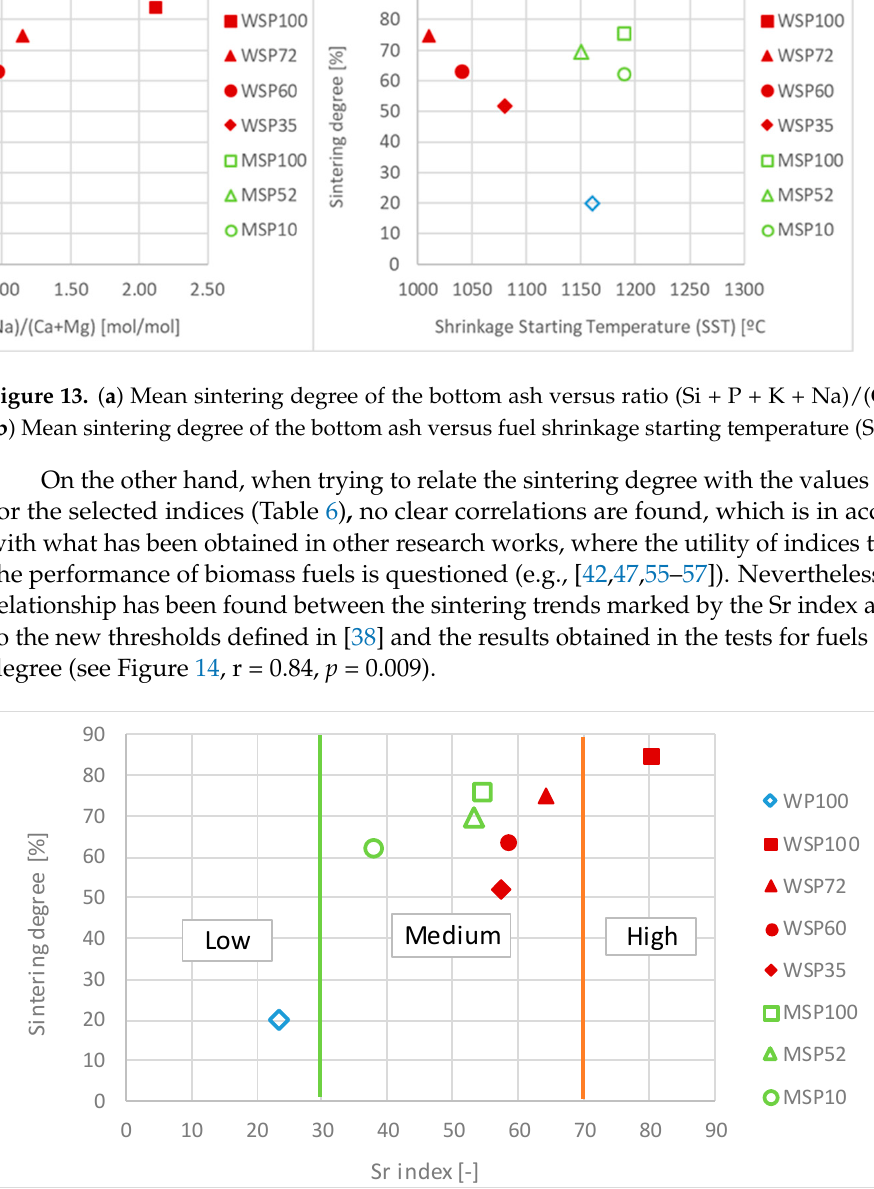
Figure 14. Mean sintering degree of the bottom ash versus Sr index.